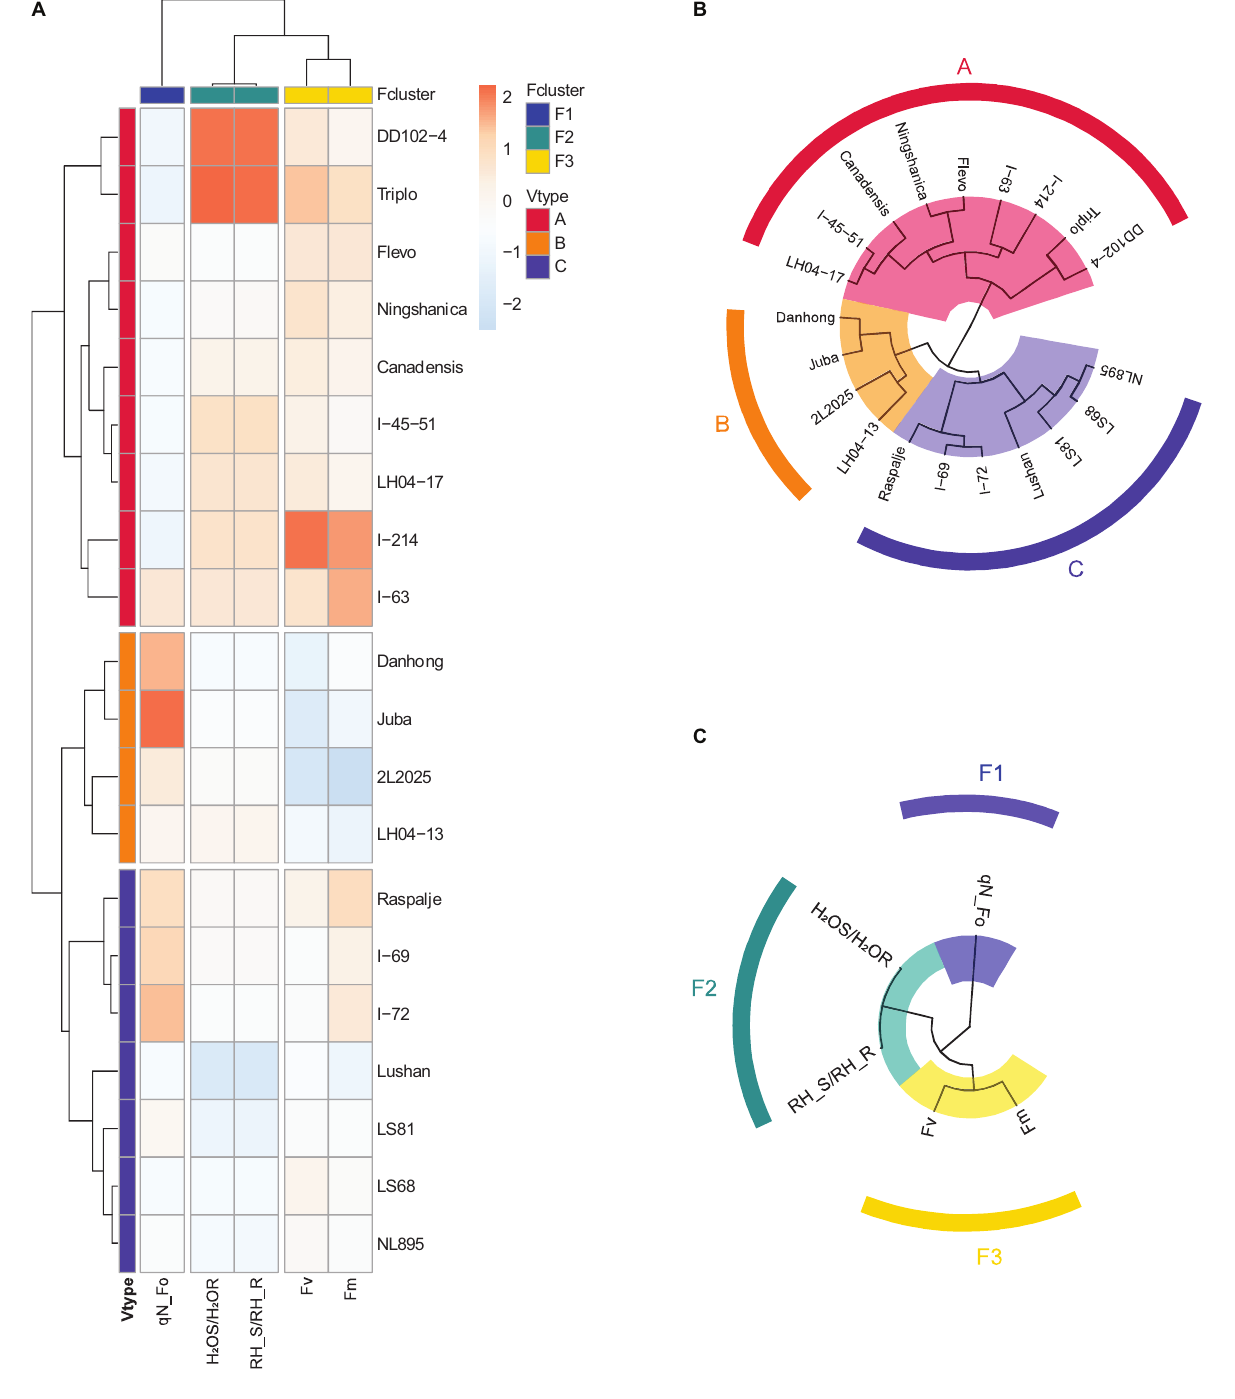
results of the Lasso method are Fv, qN_Fo, and